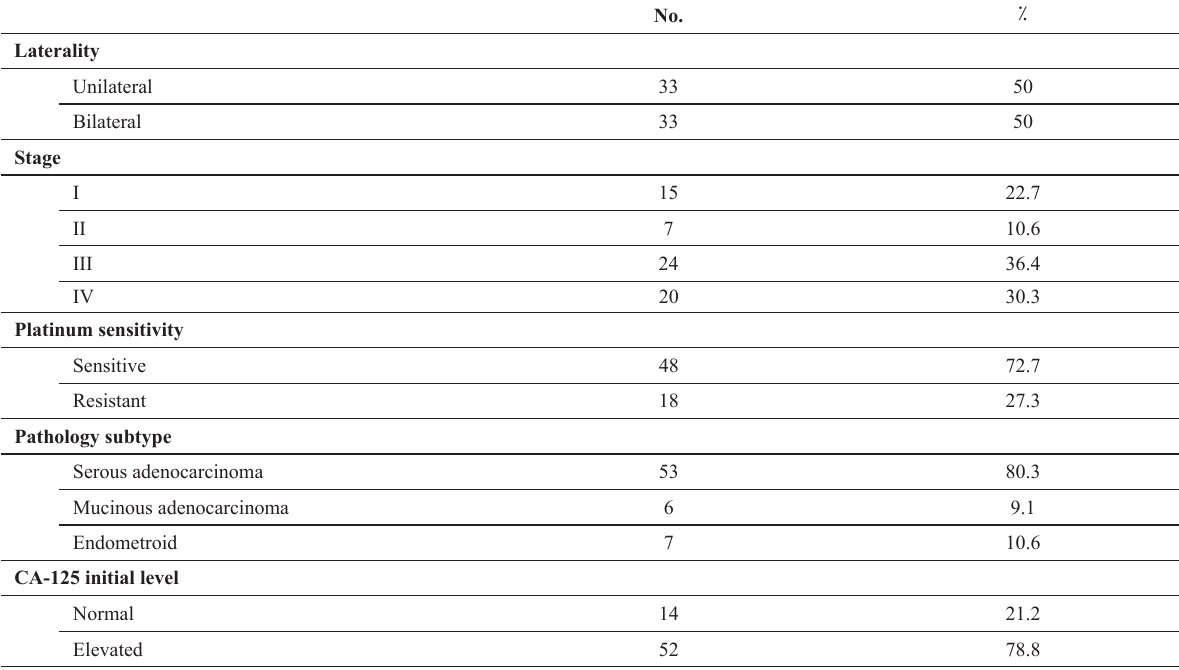
table 3: Disease characteristics.